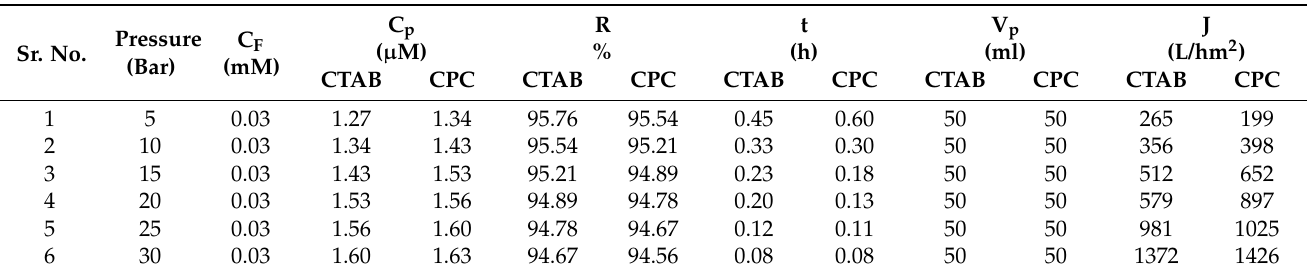
Table 5. Rejection coefficient, R%, and permeate flux, J, of Naphthol Green B for different values of pressure, at fixed dye concentration, C F , dye concentration in permeate solution, C p , filtration time, t, permeate volume, V p .